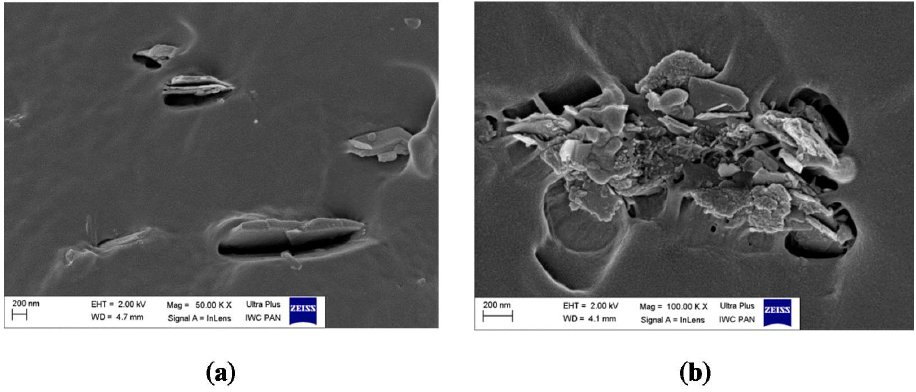
Figure 13. SEM micrographs of EN composites containing LH/CA (20%) ( a , b ).